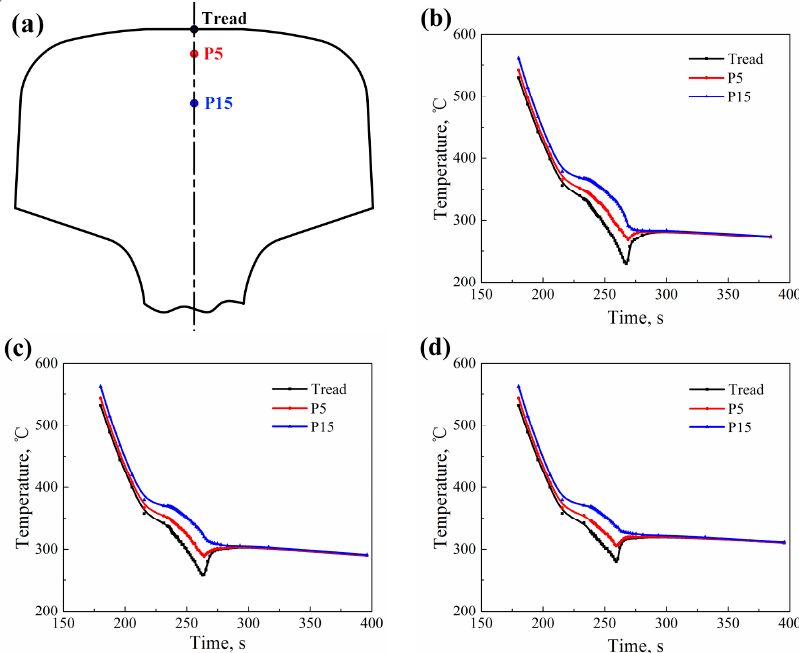
Figure 2. Finite element modeling (FEM) simulation results: ( a ) The sampling positions in the rail- head (Tread, P5, and P15); ( b )–( d ) Temperatures with the cooling time in different processes (T230, T250, and T280, respectively).